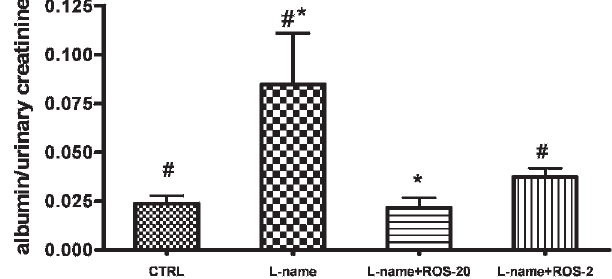
Figure 2 - Urinary albumin 5 creatinine ratio in experimental groups. # p , 0.05, * p , 0.01 when compared with the L-name